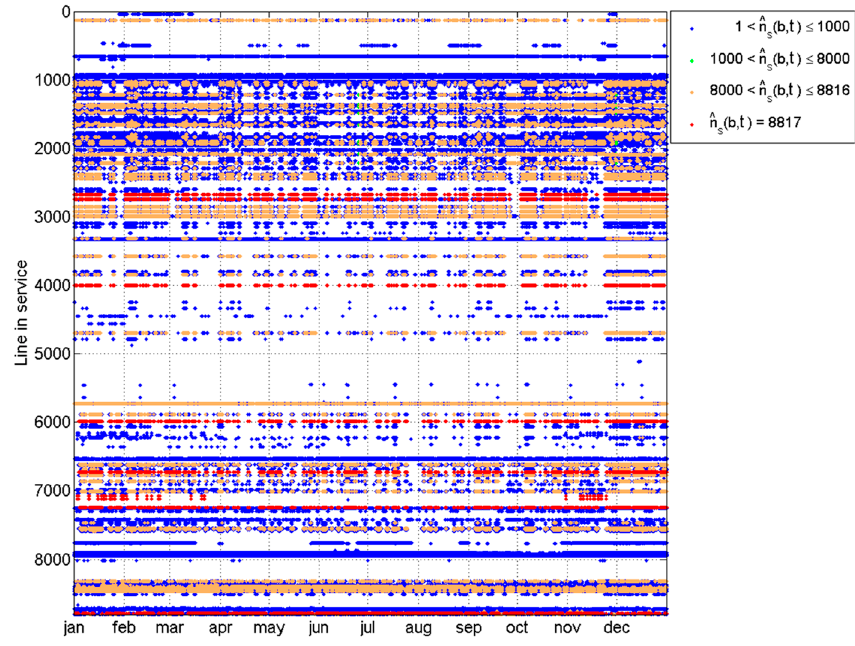
Figure 5. N − 1 overloads for each line in each hour of yearly operation.